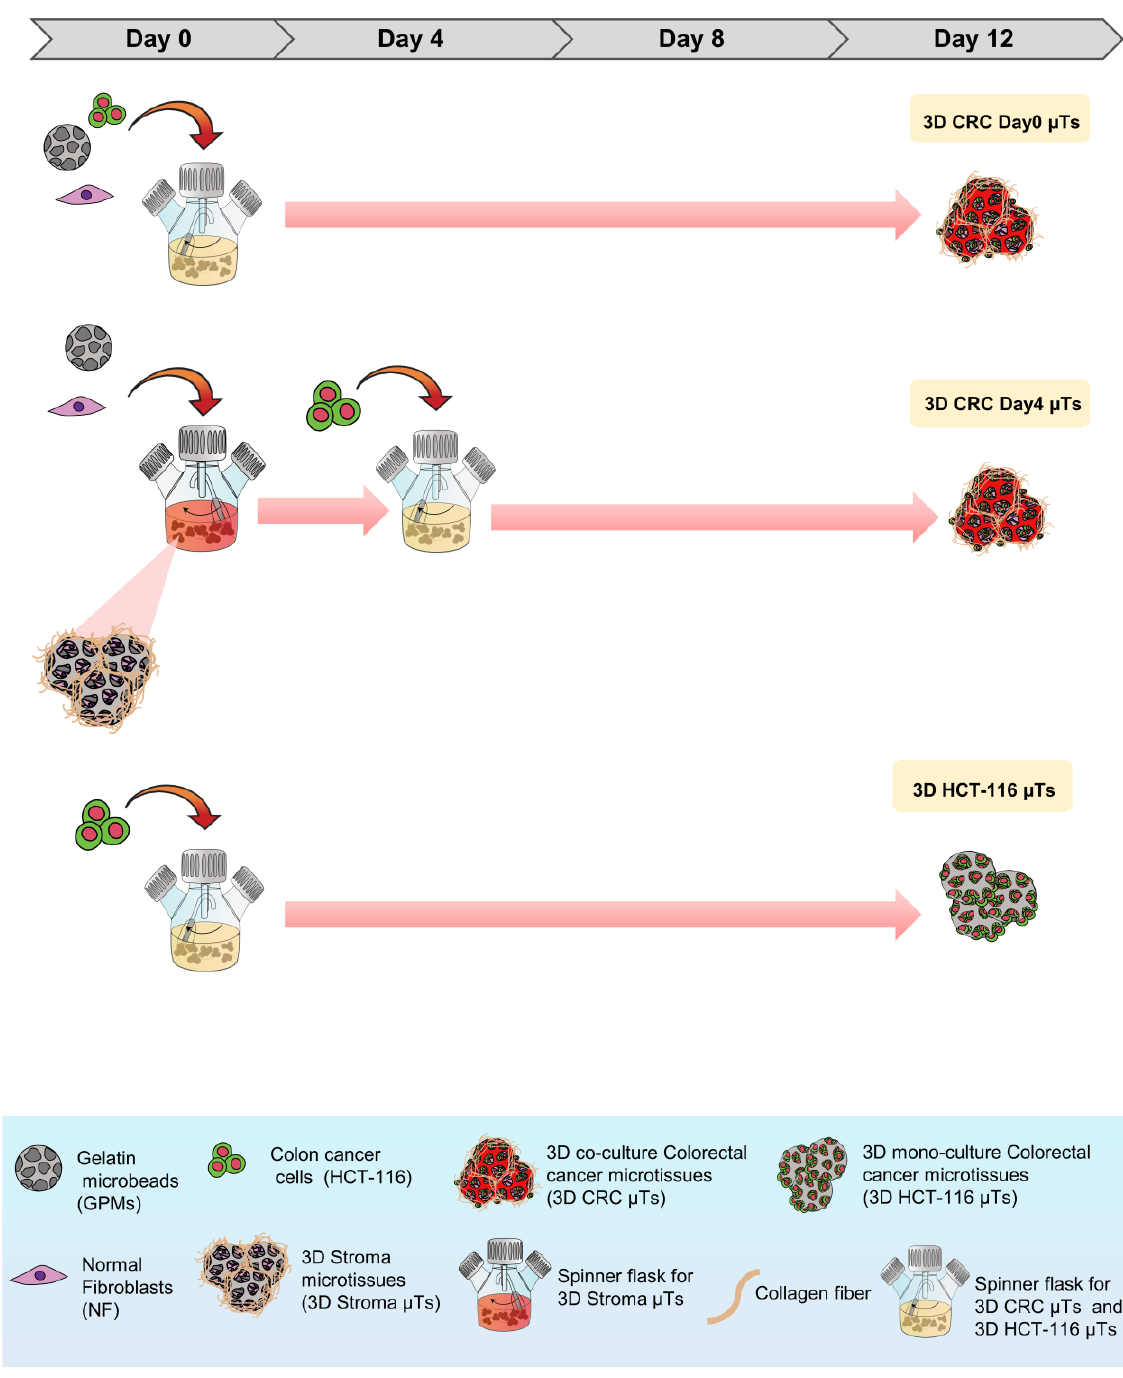
Figure 1. A schematic diagram of the method to produce the different 3D CRC µ Ts. GPMs, HCT-116 cells, and NFs were inserted into the spinner flasks to produce the 3D co-culture of colorectal cancer microtissues (the first consisted of HCT-116 cells, and NFs seeded together on day 0 of culturing, 3D CRC Day0 µTs, and the second consisted of HCT-116 cells seeded on 3D Stroma µTs on day 4 of culturing, 3D CRC Day4 µTs), and the 3D monoculture colorectal cancer microtissues (consisting of HCT-116 cells alone) (3D HCT-116 µTs) for 12 days.